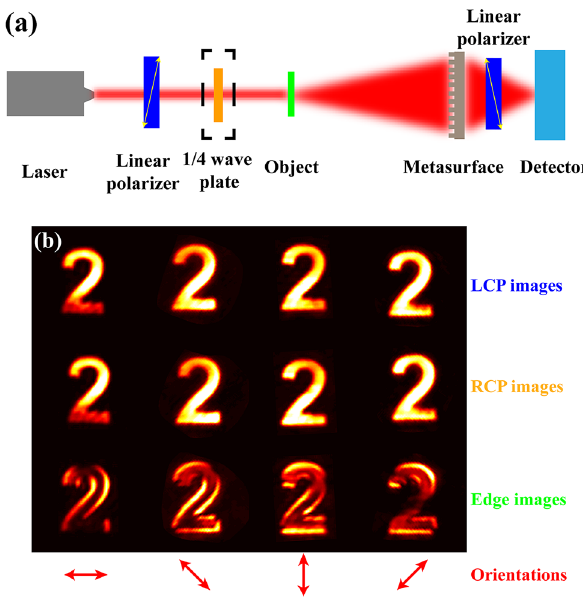
Figure 3: 1D edge detection setup and the corresponding images. (a) Schematic illustration of the measurement setup for edge detection. (b) LCP images, RCP images, and 1D edge images of the number ‘ 2 ’ at differentorientations. The rowsfrom top to bottomare LCPimages,RCPimages,and1Dedgeimages.Thecolumnsfromleft to right are images at 0, 45, 90, and 135 ° .